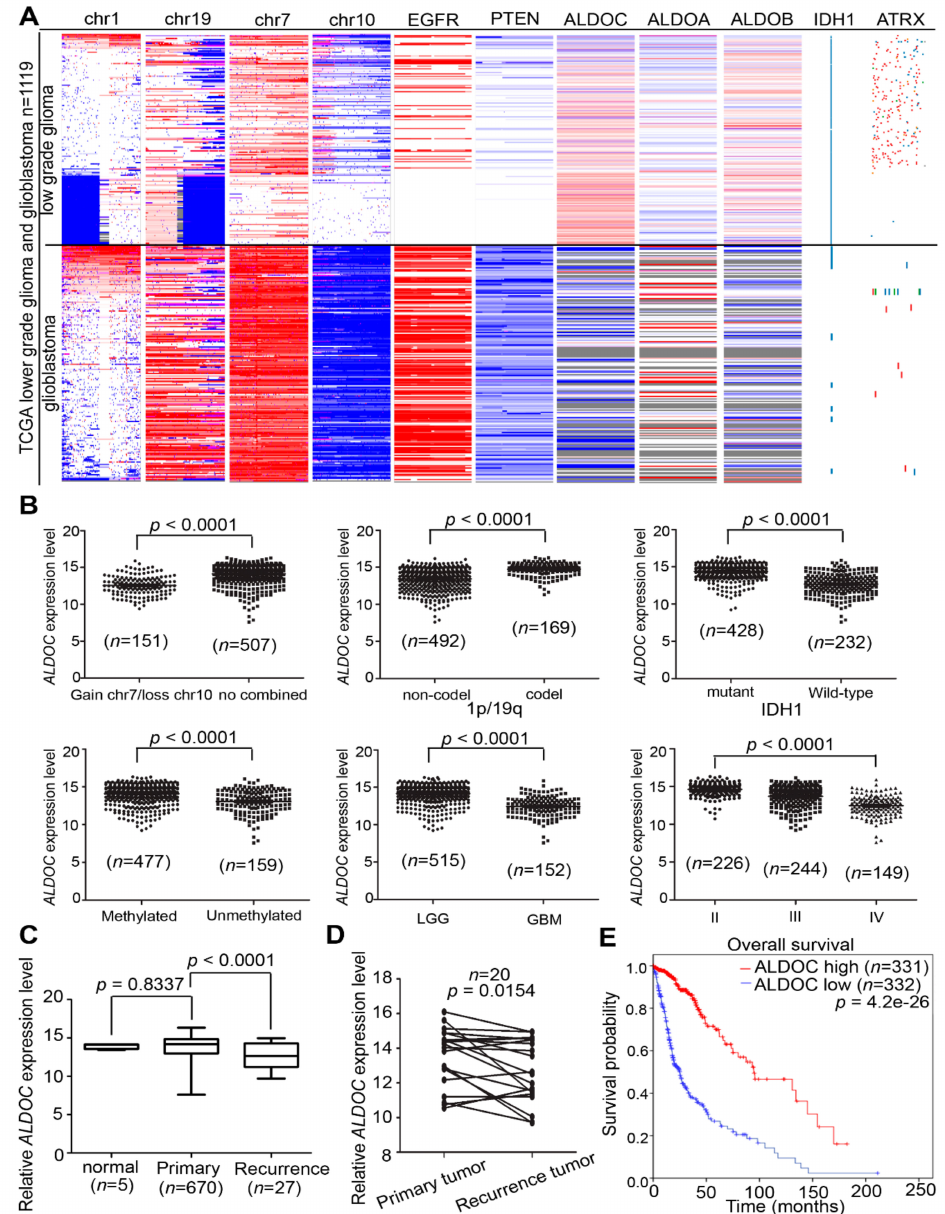
Figure 2. Downregulation of ALDOC mRNA expression in recurrence tumor associated with poor survival. ( A ) A heat map showing the endogenous mRNA expression level of the Aldolase family members ALDOA, ALDOB, and ALDOC in TCGA_ GBMLGG ( n = 1119). ( B ) a boxplot showing the distribution of ALDOC expression in clinical patients according to the chromosome (1p / 19q, 7 and 10) events and grade in TCGA_GBMLGG ( n = 1119). ( C ) A boxplot showing the distribution of ALDOC expression in clinical patients according to the normal, primary, or recurrence tumor in glioblastoma ( n = 702, p = 0.8337 and p < 0.001, respectively). ( D ) Normal adjacent tissue / tumor (N / T) pairs showing the expression of ALDOC in clinical patients according recurrence tumor or not in glioblastoma ( n = 20, p = 0.0154). ( E ) Kaplan–Meier analysis of ALDOC expression at concurrently low or high levels, with the endpoint of overall survival probability from the Kaplan–Meier Plotter database in glioblastoma patients ( p = 4.2 × 10 − 26 ). The significance of the di ff erences in B, C, and D was analyzed using a Student’s t -test. All cut-o ff values were set before analysis, and all tests were